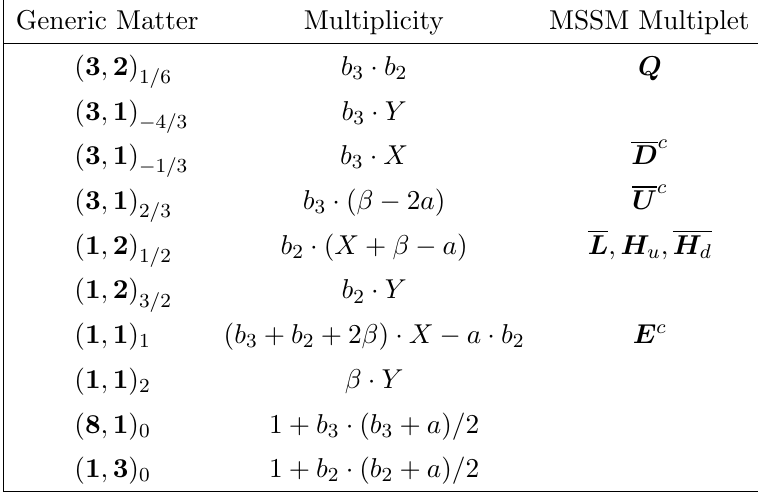
Table 2 . Generic matter representations (not including conjugates) charged under the gauge group (SU(3) (cid:2) SU(2) (cid:2) U(1)) = Z 6 , along with multiplicities for the generic matter solution of the 6D anomaly equations. This includes all the charged MSSM multiplets. The parameters (cid:12); X; Y are de(cid:12)ned in eq.